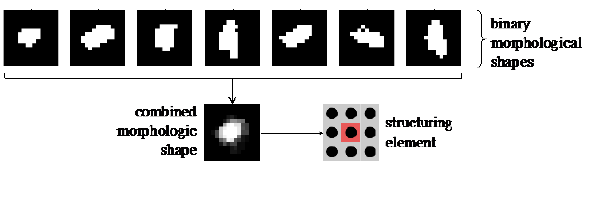
Figure 6. Finding structuring element for identifying BPHs